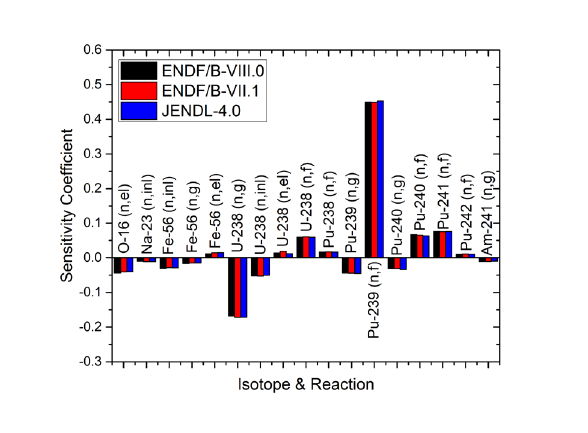
Figure 4. Sensitivity coe ffi cient of oxide core for di ff erent nu- clear data libraries